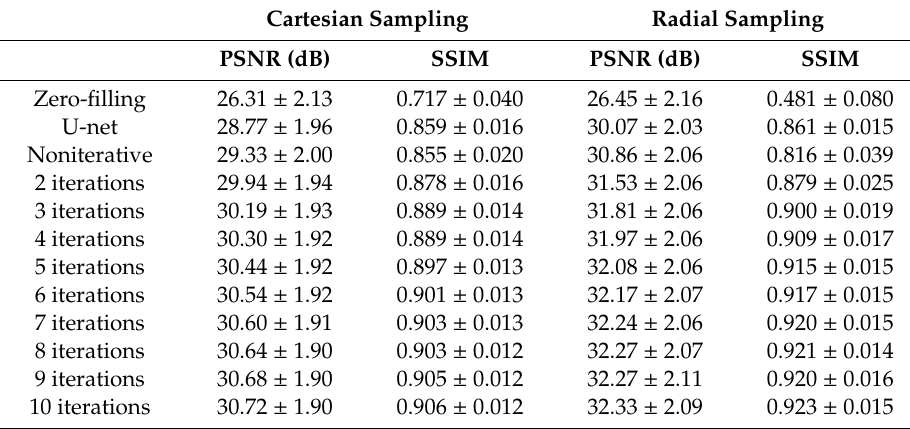
Figure 4. Image reconstruction results obtained with a sampling mask of 10%. Columns correspond to ground truth and results obtained using the zero-filling, image-space-treated U-net, other noniterative, and proposed iterative methods (left to right). Rows correspond to the Cartesian and radial sampling masks of reconstructed images and error maps compared to fully sampled images. Table 1. Quantitative results (mean ± SD) in terms of peak signal-to-noise ratio (PSNR) and structural similarity index (SSIM) obtained using different methods with Cartesian and radial sampling masks of 10%.